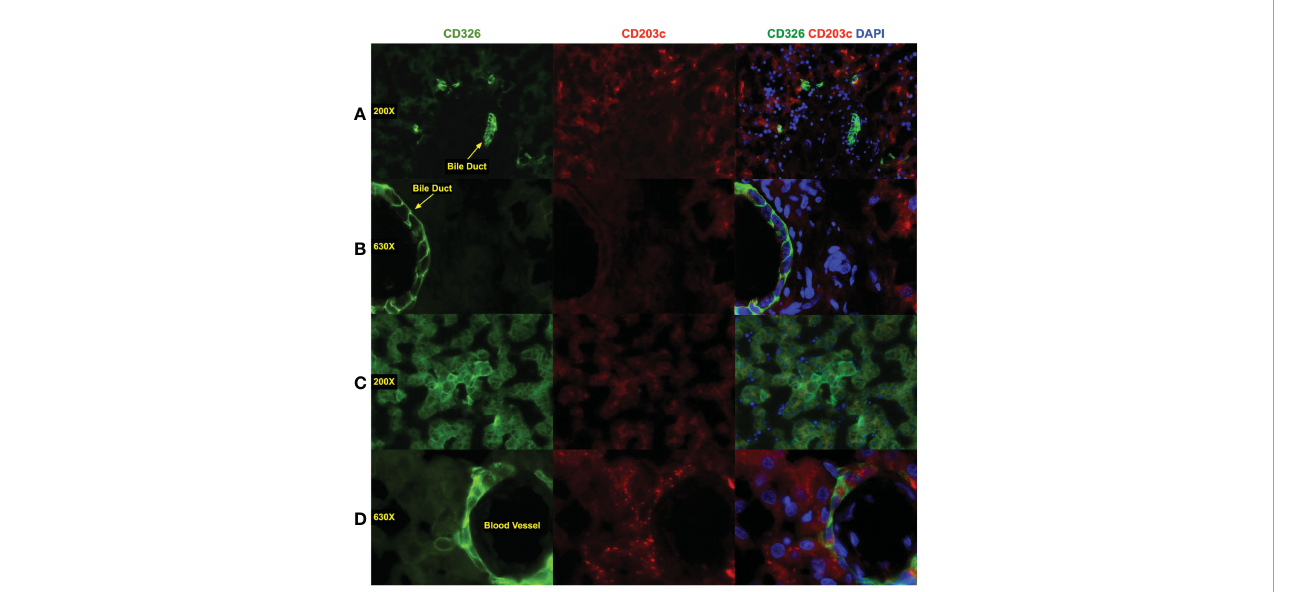
FIGURE 4 Immuno fl uorescence staining of fetal liver. Liver was fi xed and frozen sections prepared that were stained with antibodies against CD326 (AlexaFluor 488, green), CD203c (AlexaFluor 568, red), and DAPI to stain nuclei (blue). CD203c was stained using clone 97A6 (A, B) and clone FR3-16A11 (C, D) . Images were photographed using a Leica CTR6500 microscope with 200X (A, C) and 630X (B, D) magni fi cation. Image analysis was performed using Media Cybernetics In Vivo and Apple iPhoto software. Color channels were enhanced individually, with uniform application of all processes, before generating composite, shown in the composite photomicrographs in the left column.